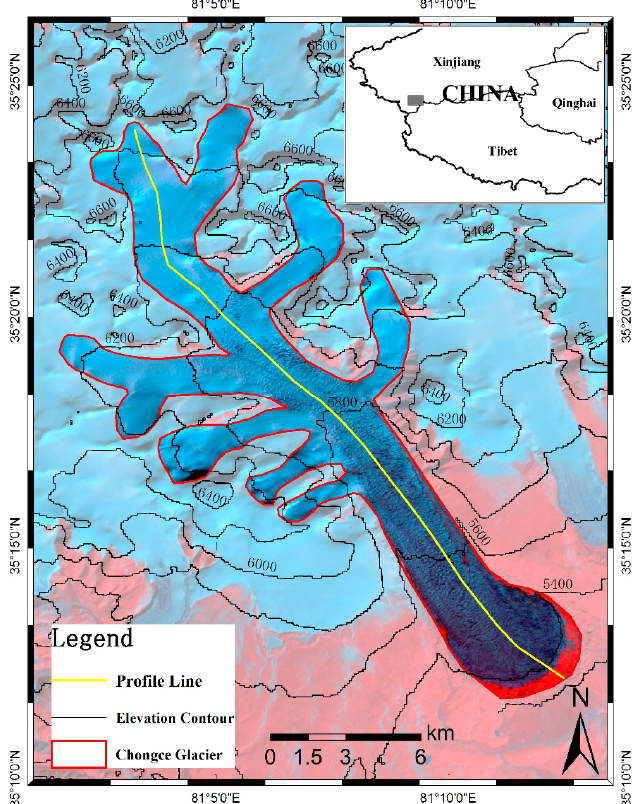
Figure 1. Landsat-5 image of Chongce Glacier in the West Kunlun Mountains. The translucent mask was employed on the surrounding mountain area for highlighting the study area, which is outlined with the red line. The red area means the surrounding non-glacial mountain area. Both the light-blue and dark-blue are the ice or snow coverage, respectively. The location is indicated in the inset.